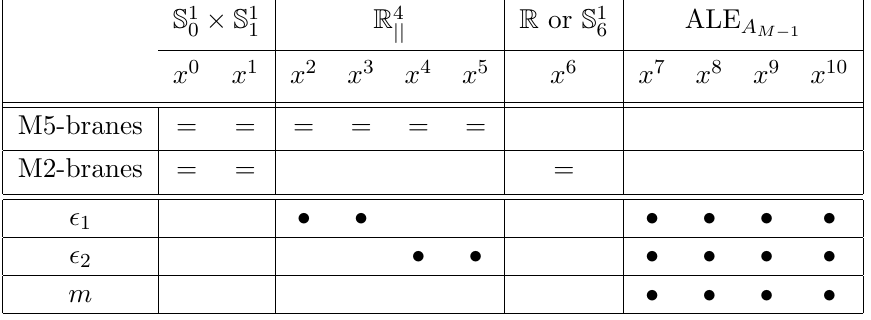
Table 4 . BPS con(cid:12)gurations of M5-branes probing a transverse orbifold geometry with M2-branes stretched between